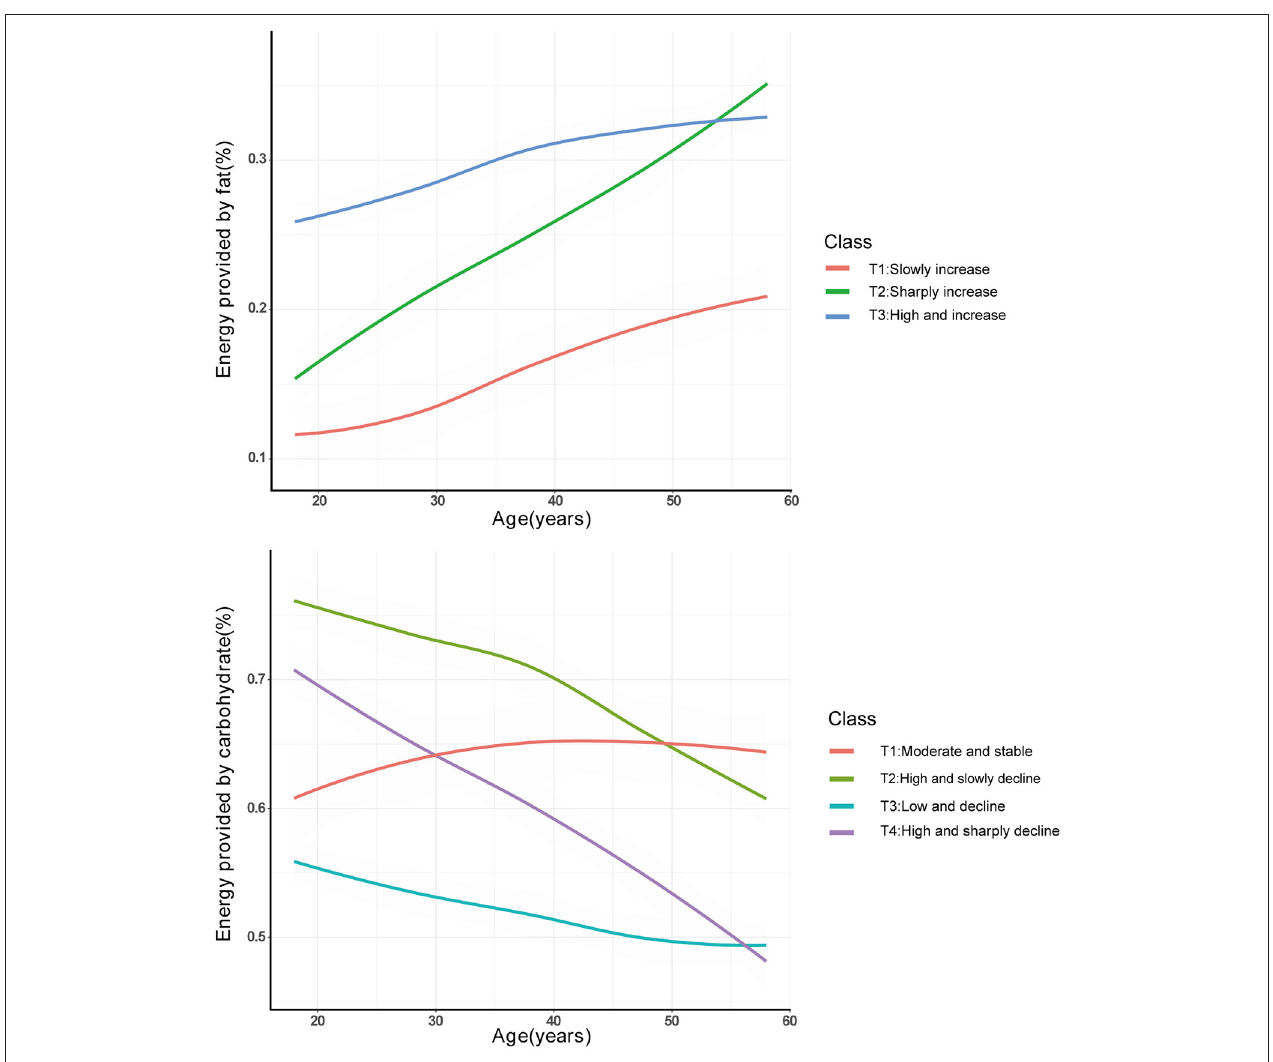
FIGURE 2 | Trajectories of FER and CER from the CHNS (1991–2011) by latent class trajectory modeling. FER, energy provided by fat; CER, energy provided by